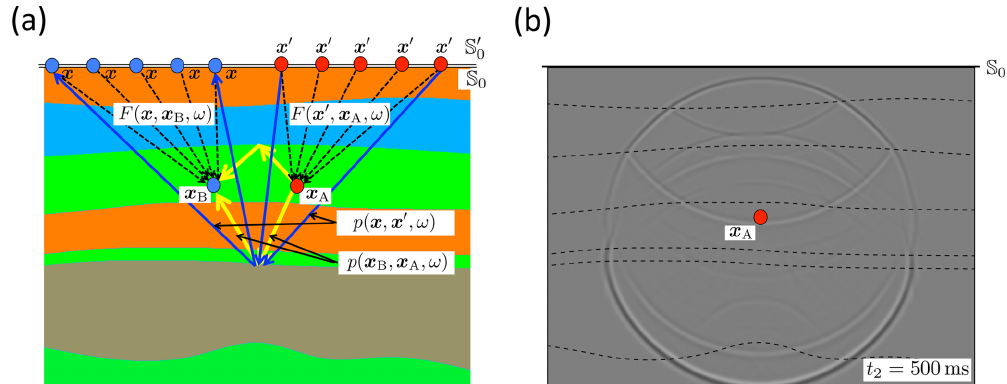
Figure 12. (a) Principle of modified source–receiver redatuming. (b) Snapshot of the wave field p( x B , x A ,t) at t 2 = 500ms for all x B .